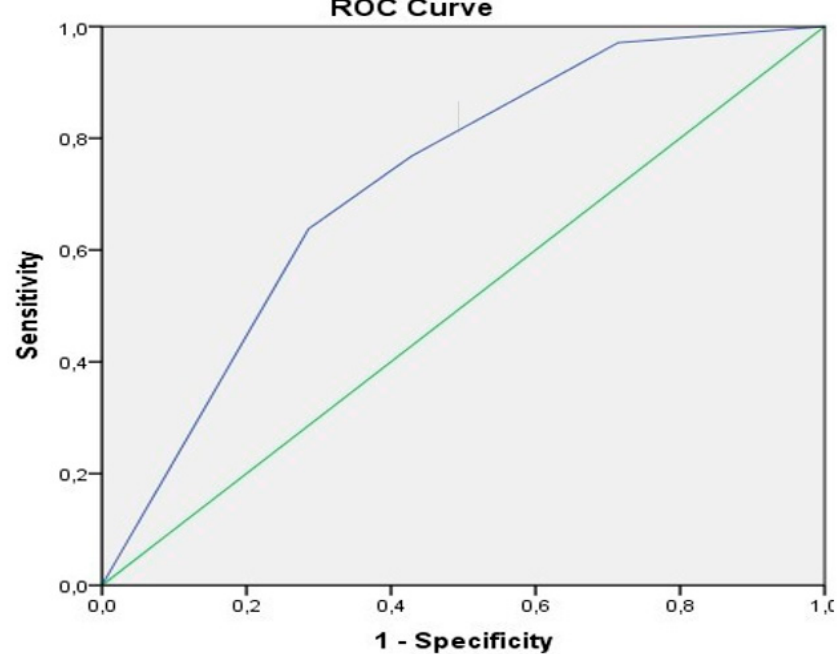
/ Clavien (D / C) grade ≥